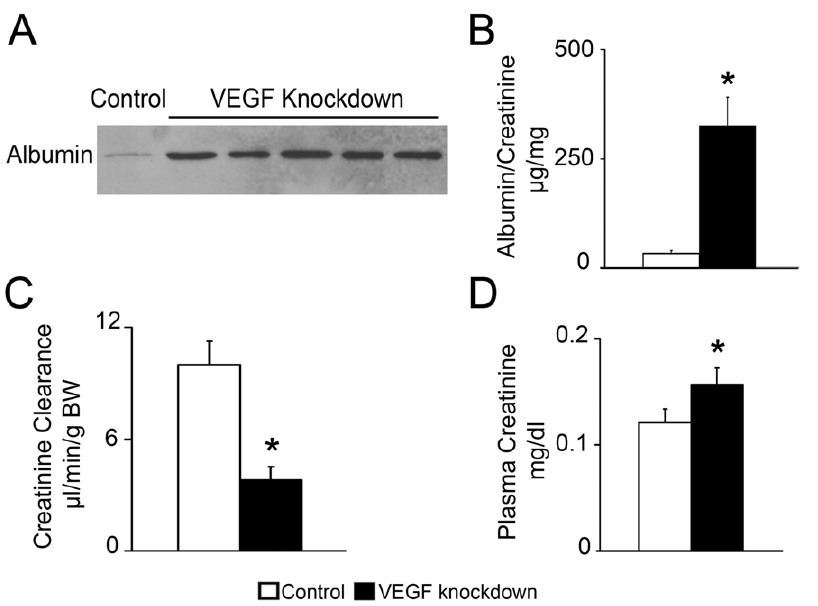
Figure 4. VEGF knockdown induces proteinuria and acute renal failure. (A) Immunoblot shows severe albuminuria in VEGF Knockdown mice. (B) ELISA: urinary albumin/creatinine ratio in VEGF knockdown mice is 10-fold higher than in controls. (C) Creatinine clearance is 62% lower in